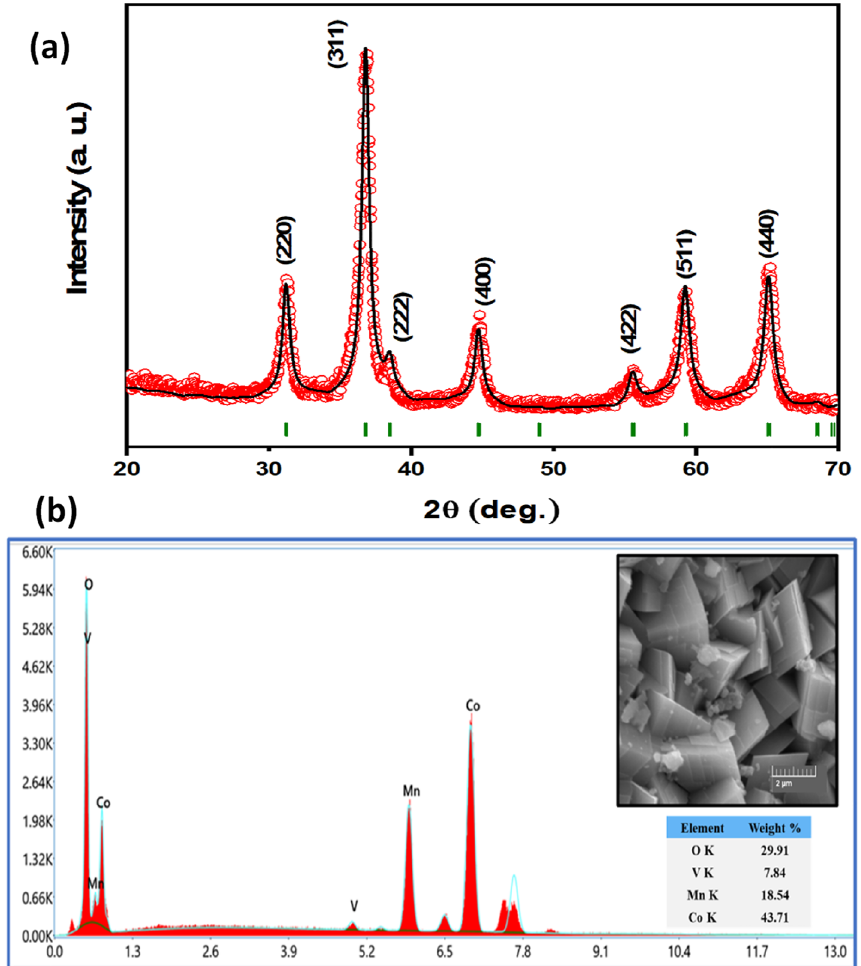
Figure 12. (a) XRD spectrum; (b) EDX spectrum and SEM image of V x -MnCo (x = 0.3) MCs after stability test.